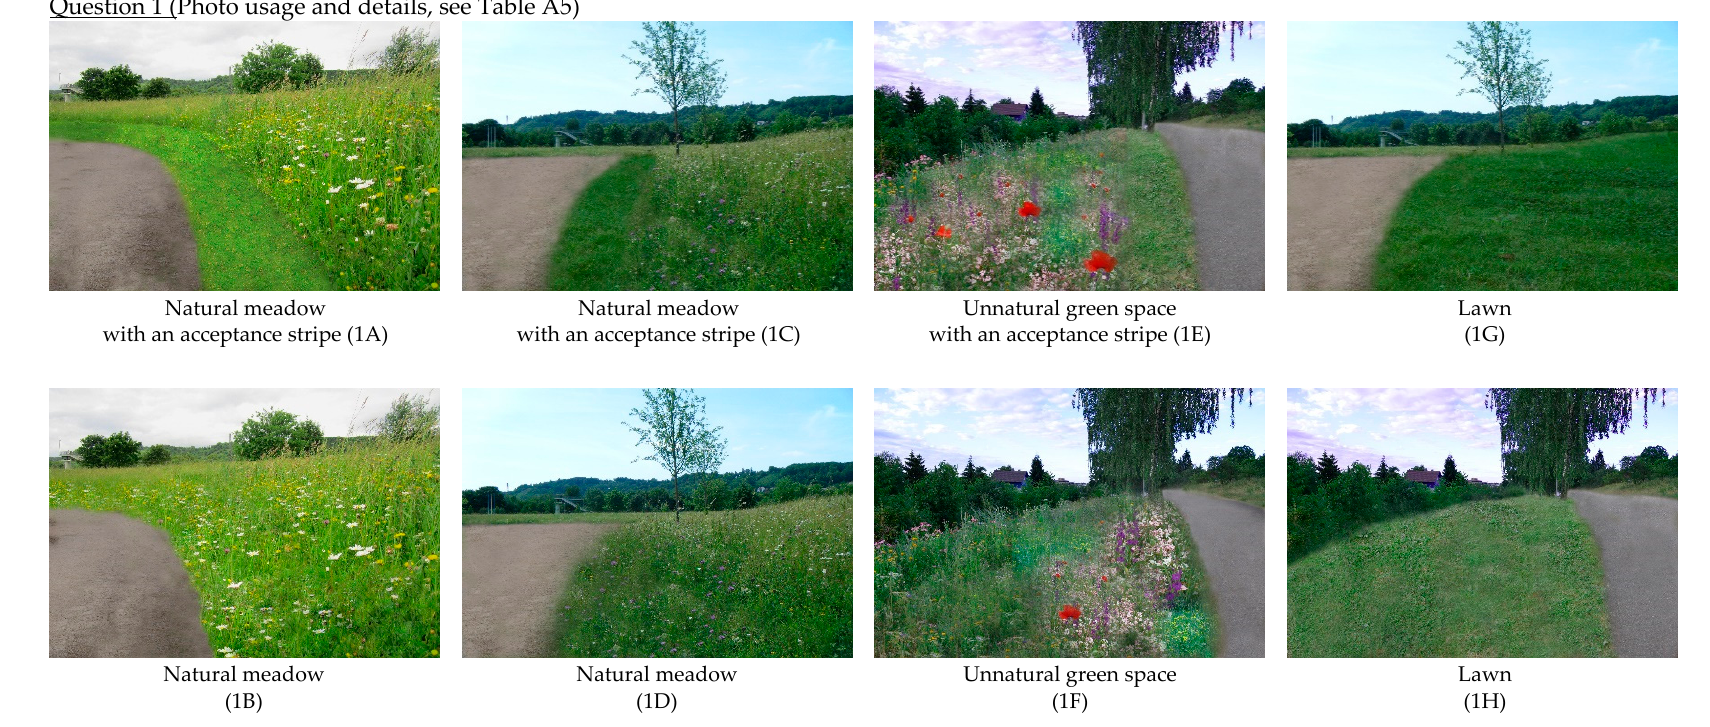
Figure 1. The aim of Question 1 was to establish whether a preference existed among the surveyed participants for a certain type of green space. Alternatively, such a preference might depend on the presence of an acceptance stripe only. For further explanations, see text.